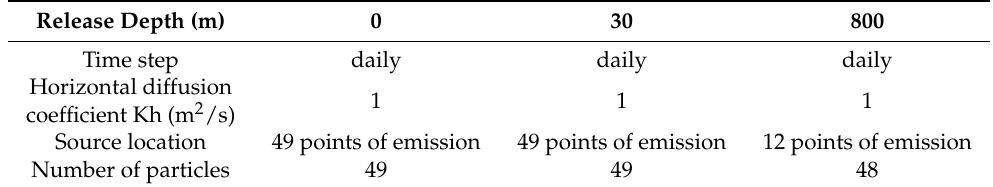
Table 1. Configuration of point discharges of particles at each depth layer in the ocean